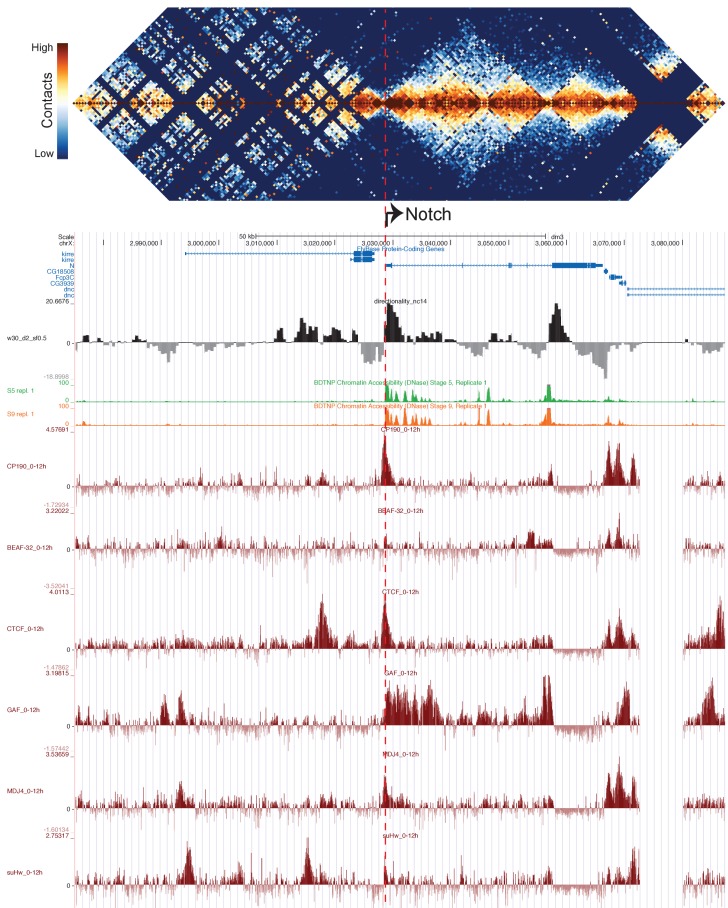
TAD structure corresponds to mapped polytene structure at the Notch locus.Hi-C map of the Notch locus, prepared as in Figure 5.